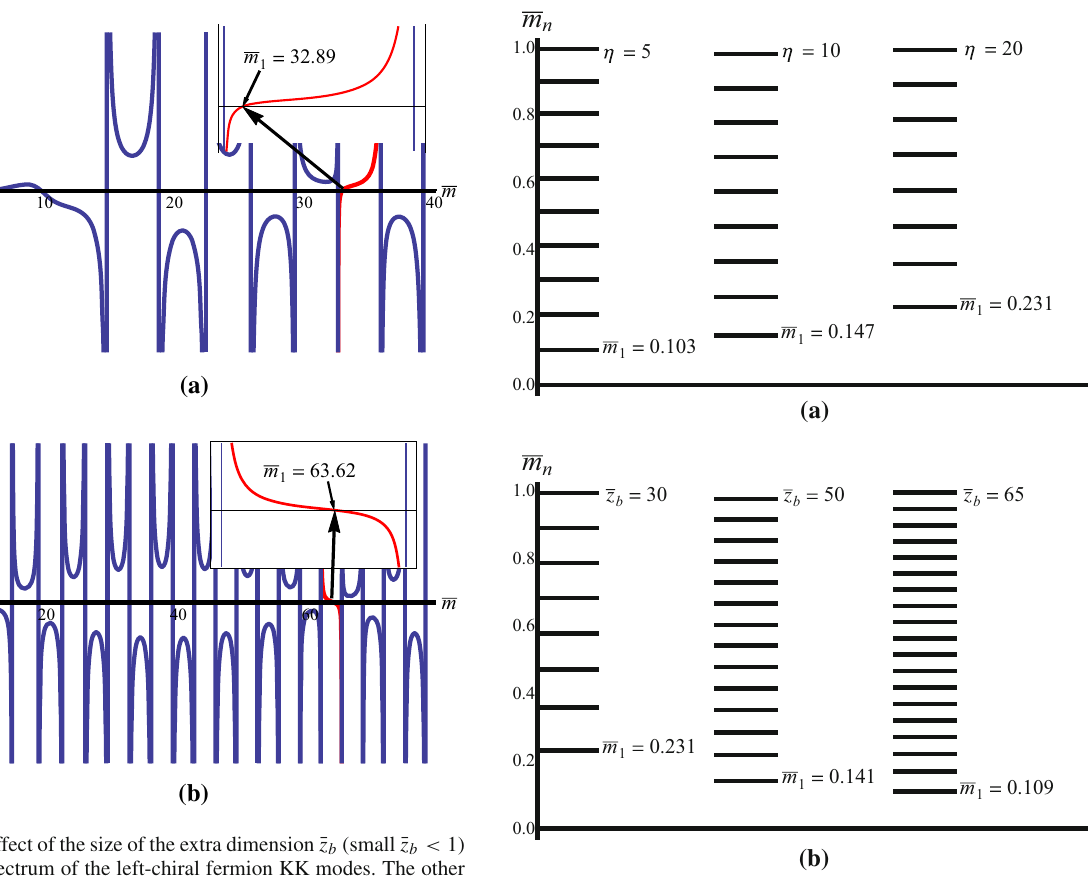
Fig. 11 The mass spectrum of the left-chiral fermion KK modes for different parameters. The parameter k is set to k = − 3 ˆ R ( 4 ) is the four-dimensional Riemannian Ricci scalar where ( 4 ) ( 0 ) made out of g μν = η μν + h μν ( x ) . Thus the effective four- dimensional Planck scale M Pl is [61]